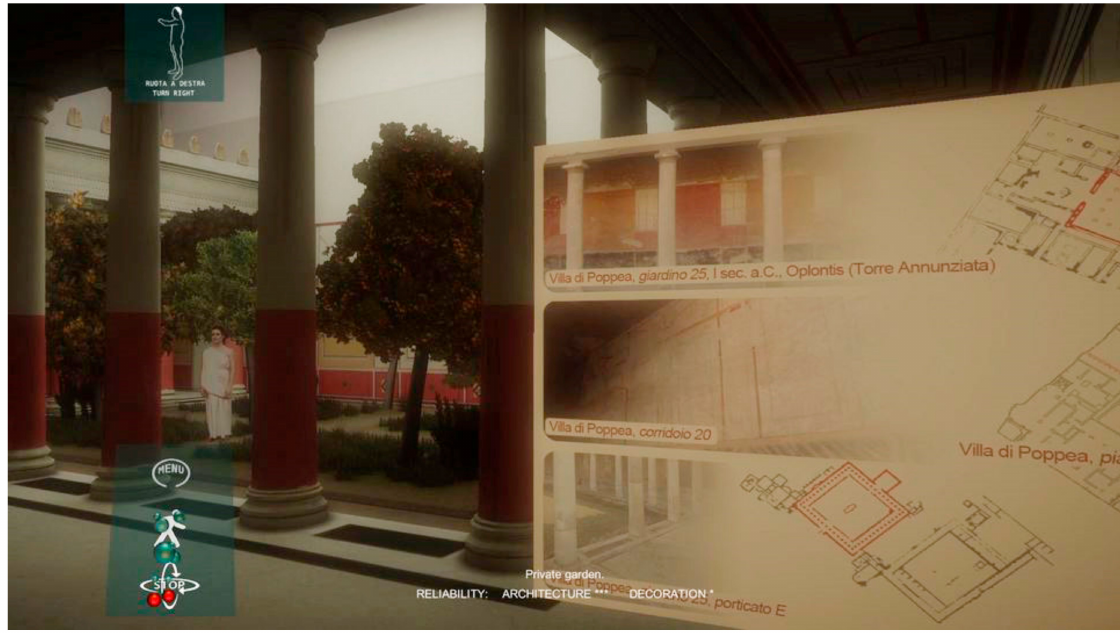
Figure 3. Livia’s Villa, private garden. Panels showing the typological comparisons used for the virtual reconstruction and caption with levels of reliability in the architecture and